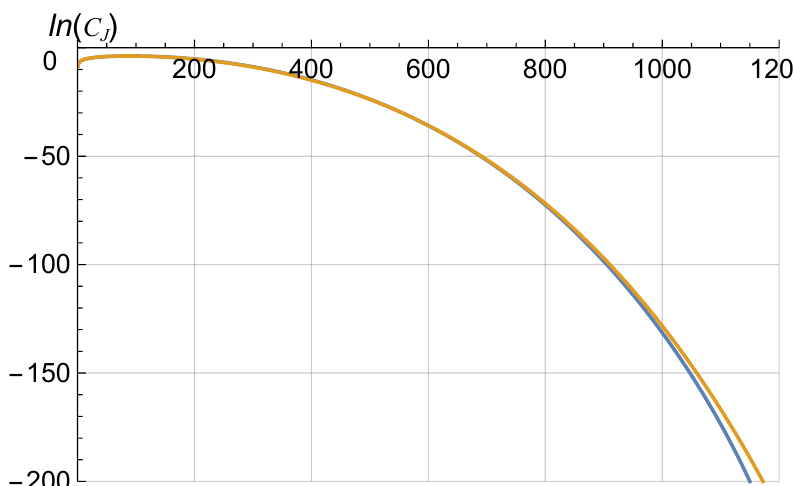
Figure 2 . Log-plot of Legendre expansion coe(cid:14)cients C J by the saddle point (blue line) and by the algebraic method of section A.1 up to J =